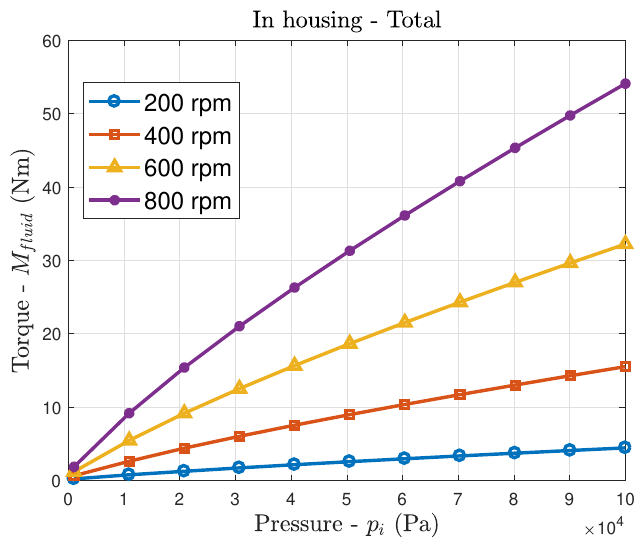
Figure 5. Total fluid friction torque as a function of the pressure at different rotational velocities.